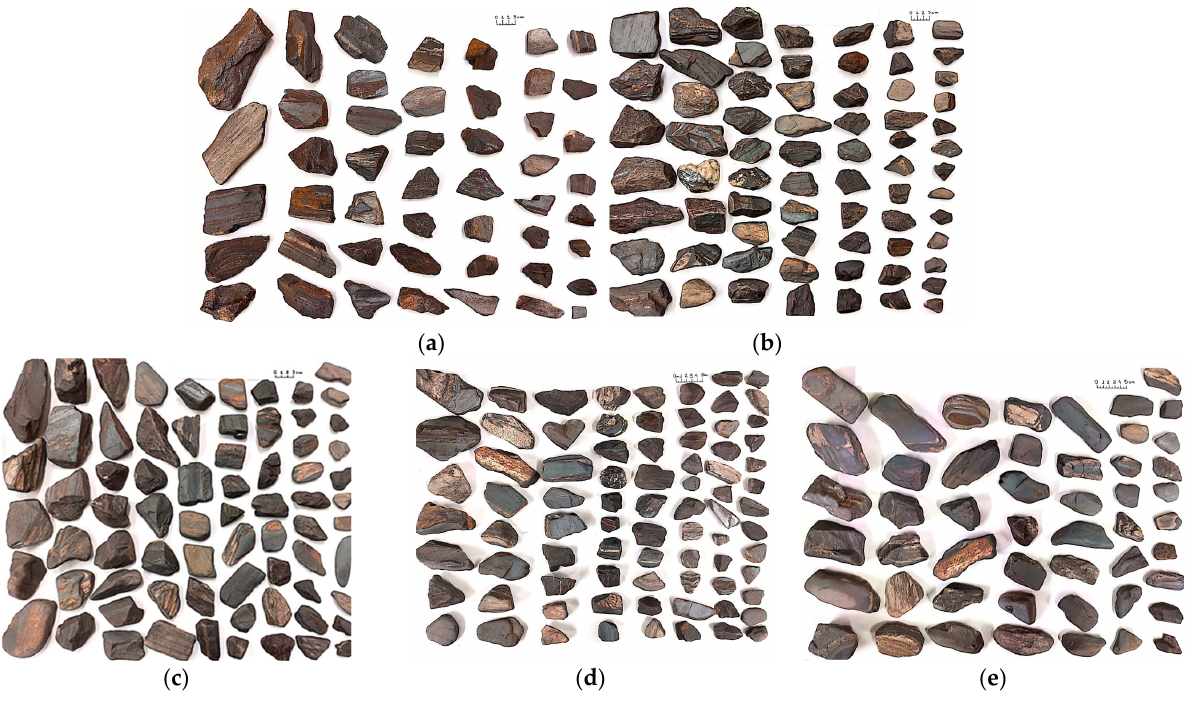
Figure 4. Pebbles from rounding grinding: ( a ) test feed pebbles; ( b ) pebbles after a 30-min test in Mill 1; ( c ) pebbles after a 150-min test in Mill 1; ( d ) pebbles after a 30-min test in Mill 2; ( e ) pebbles after a 90-min test in Mill 2.